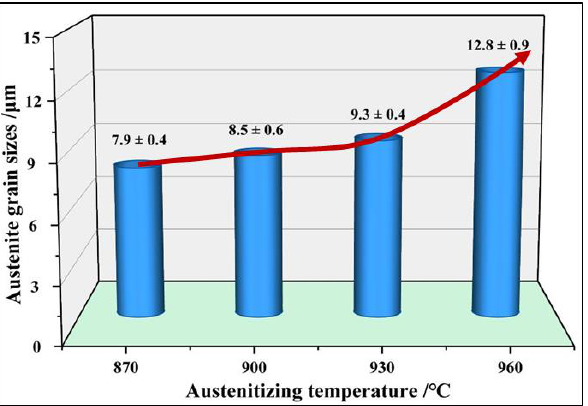
Figure 9. The variation in austenite grain sizes at different austenitizing temperatures.